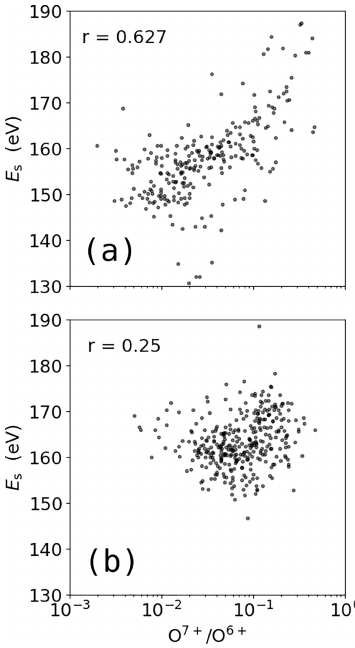
Figure 5. Scatter plots of (a) T h–s1 and (b) T h–s ⊥ against O 7 + / O 6 + for Carrington rotation 2089. Pearson linear correlation coefficients are printed on the plots. Both have moderate and neg- ative values of r , with T h–s ⊥ having a slightly stronger correlation.